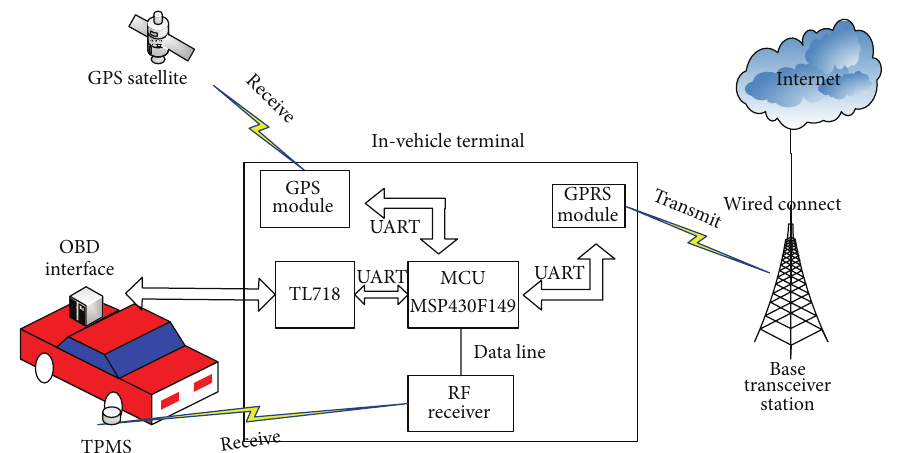
Figure 2: Hardware design structure and function of the